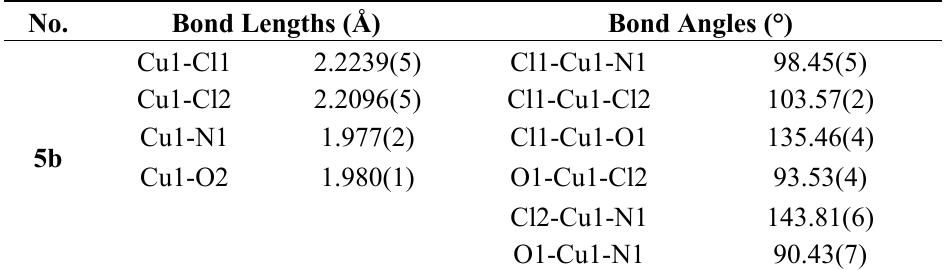
Table 2. Selected bond lengths and bond angles in copper complexes 5b , 5h , 5i and 5j .